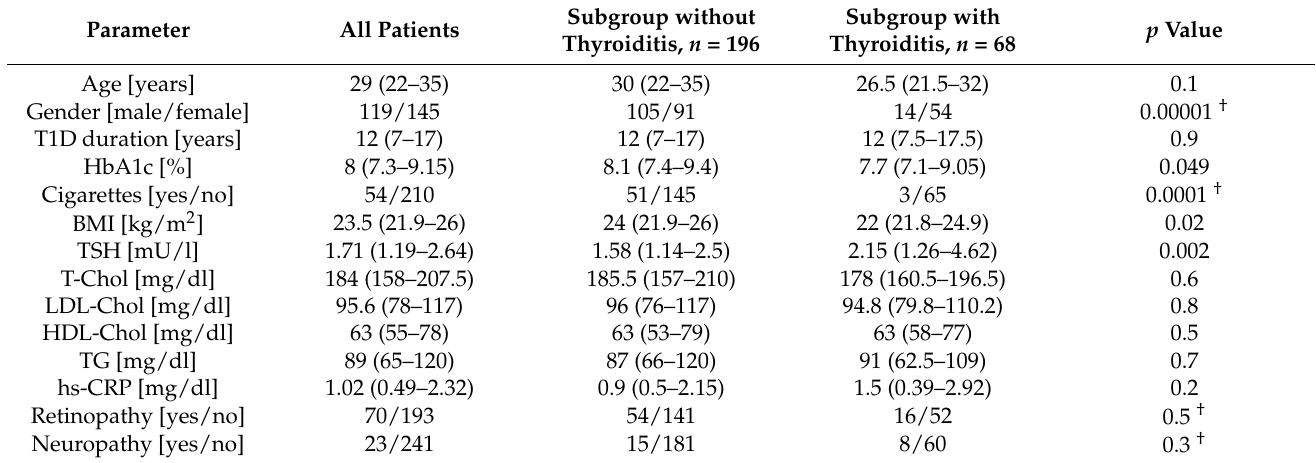
Table 1. Characteristics of the study participants. Comparison of subgroup diagnosed with thyroiditis with subgroup without thyroiditis [number or median (interquartile range, IQR)]. Mann-Whitney U test; † χ 2